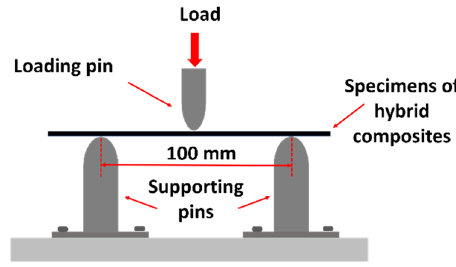
Figure 6. Three-point bending testing.